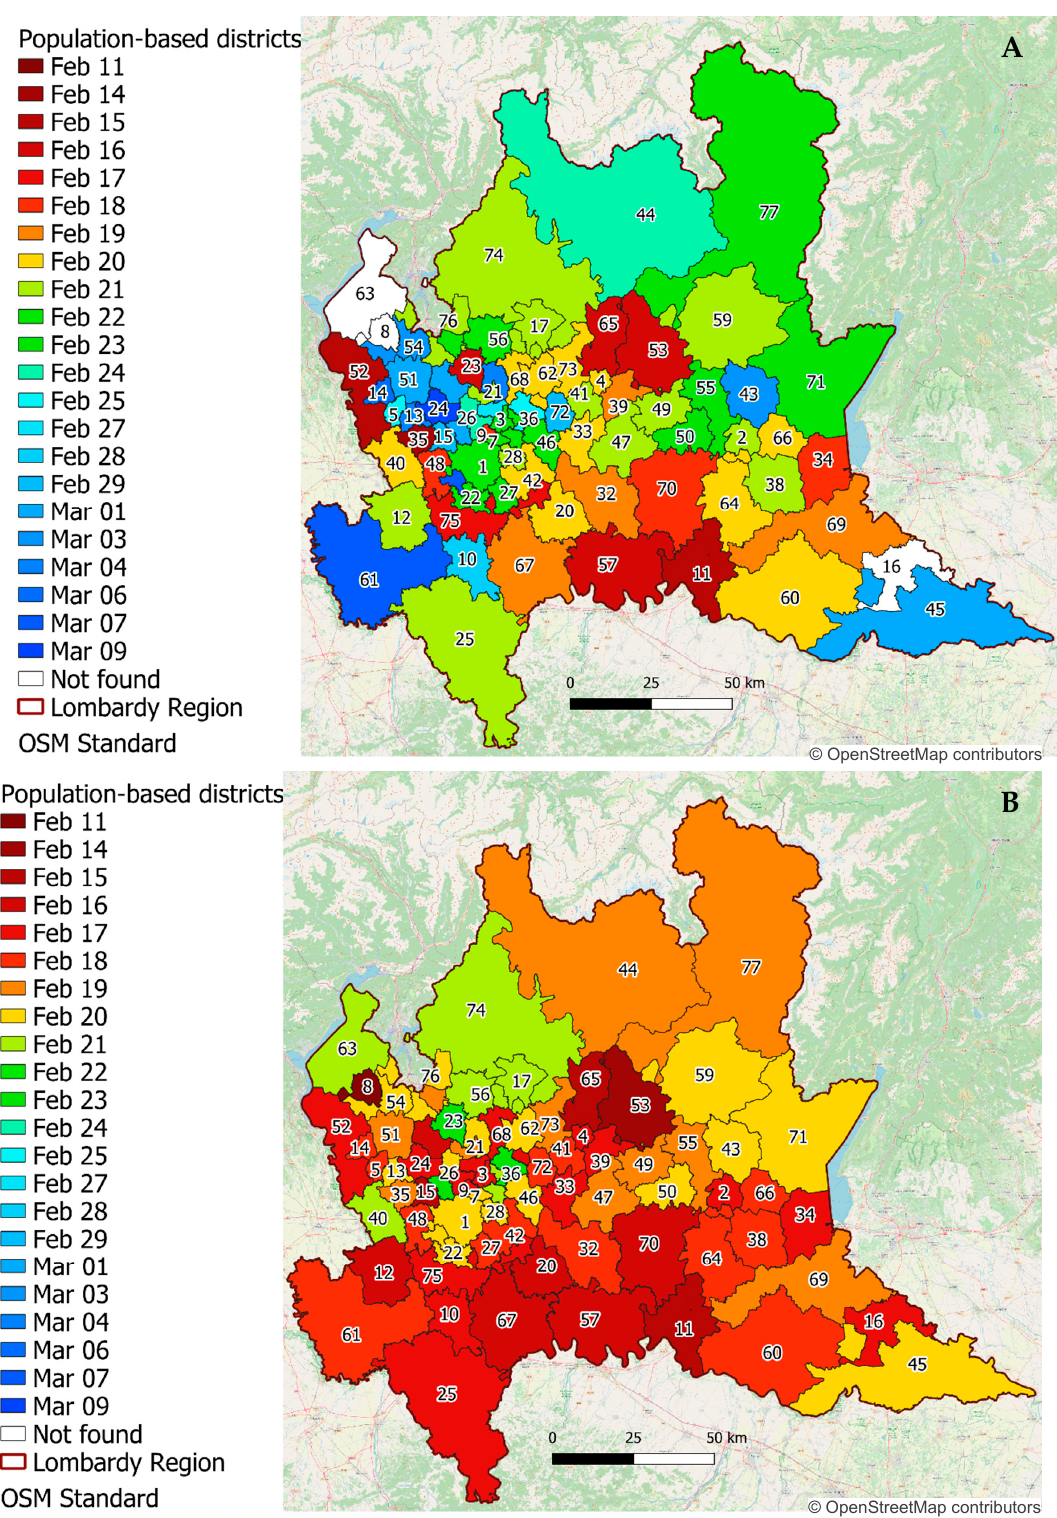
Figure 9. Mapping of the 77 population-based clusters with their progressive identification label superimposed, where color-coding represents the day of the detected inflection point (see legend), ( A ) considering the ambulance dispatches-based COVID-19 score and ( B ) the normalized number of emergency calls.